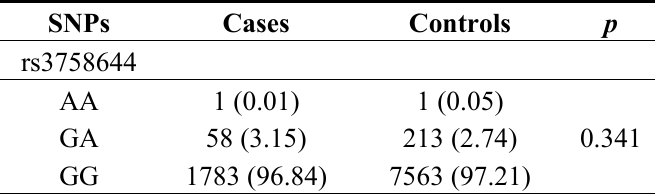
Table 2. Genotypic and allelic distributions of single nucleotide polymorphisms in LRP5 gene among Han Chinese in